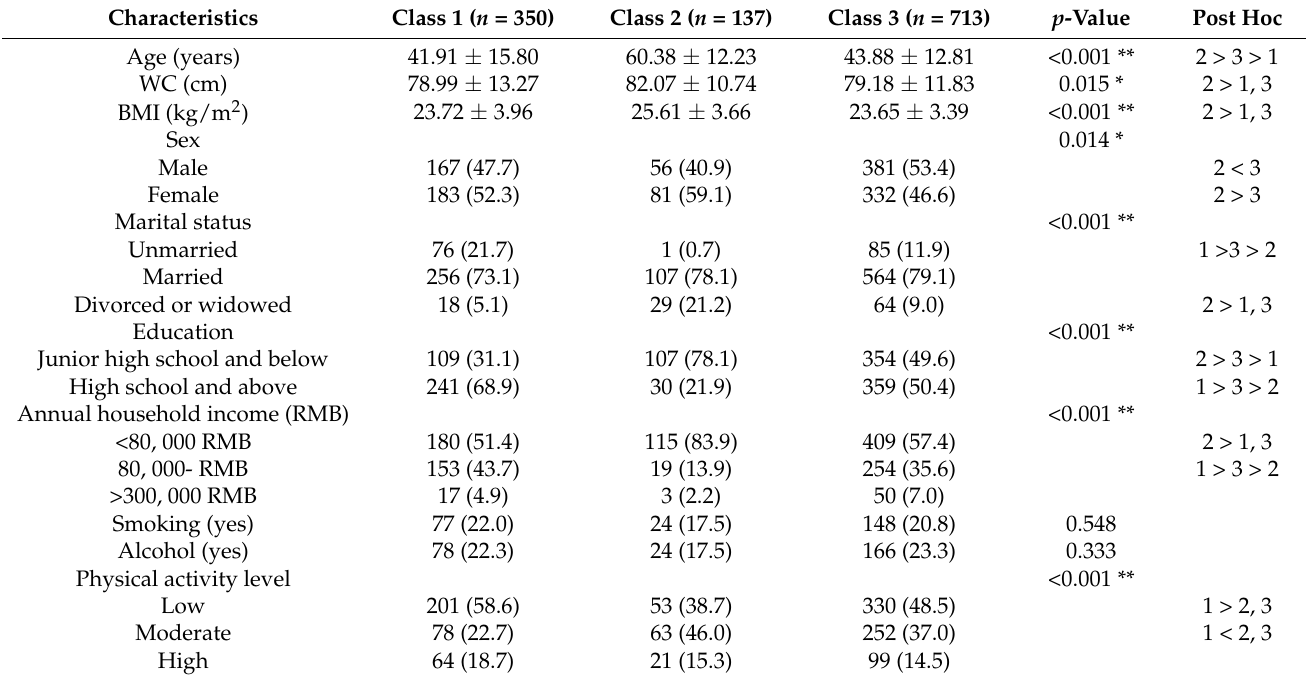
Table 3. Participants characteristics in 3 classes of sleep patterns.